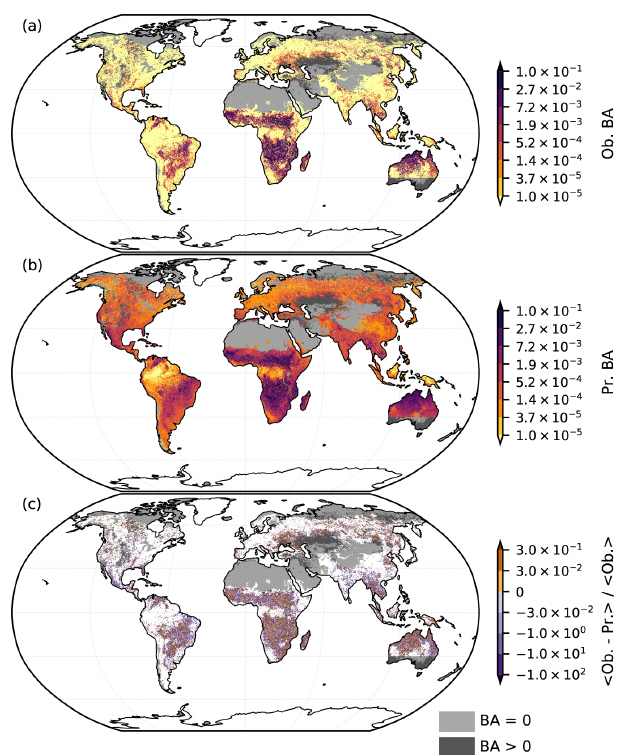
Figure 2. (a) Average observed (Ob.) BA derived from the GFED4 BA dataset (Giglio et al., 2013). (b) Out-of-sample predictions (Pr.) by the ALL model on the validation dataset. (c) Relative prediction error of the ALL model calculated by taking the mean of the differ- ence between observations and predictions divided by the mean ob- servations. While the predictions in panel (b) are qualitatively very similar to the observations in panel (a) , there is an overestimation of low BA. Areas with very low or 0 observed BA (a) are omitted from panel (c) to avoid division by (nearly) 0. Despite the visual exag- geration of the errors, which are generally small, there is no overall pattern. Note that sharp data availability boundaries (e.g. in western Asia, southern Australia) are introduced by the AGB dataset. Grey shading indicates regions with fire data availability, but where one or more of the other datasets is not available. Light grey indicates regions where mean BA is 0, with dark grey representing regions with non-zero mean